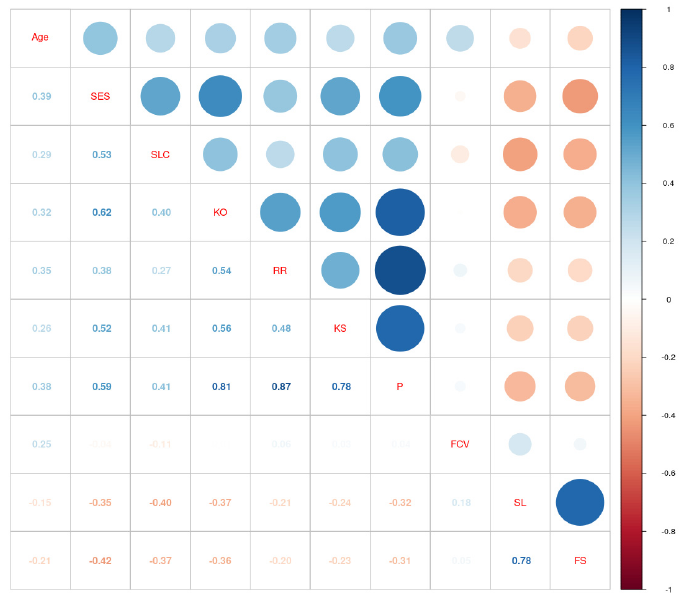
Figure 1. Corrplot illustrating correlations between continuous variables. Analysis of Pearson’s r correlation coefficients revealed all statistically significant re- lationships. A positive correlation was observed between the self-esteem and all resilience subscales ranging from small magnitude with family relation (RR) r = 0.38**, to moderate with personal competence (KO) r = 0.62**. Scales of anxiety were positively correlated with each other; the exception is general anxiety because a higher score means lower anxiety. It is worth noticing, that all variables significantly correlate with age, and only death fas- cination and personal death anxiety were correlated negatively. The magnitude of this relationship is rather small. All subscales were examined in respect of differences between subgroups created by the vaccination status. The subjects were divided into two mutually exclusive sets: those who have received at least one COVID-19 vaccination dose, and those who did not receive any vaccination. The results are presented in Table 3. Table 3. Differences in all subscales in regard to vaccination status. Dependent variabls